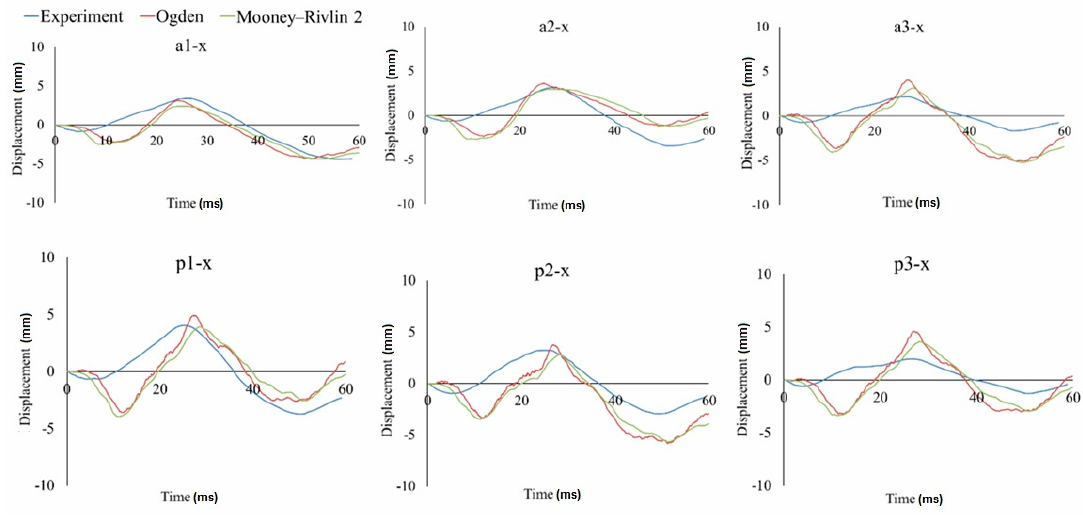
Figure 5. Displacement-in-time characteristics of the markers in the frontal (a) and rear columns (p) in the X-direction using the hyperelastic material models based on the second Mooney-Rivlin and Ogden constitutive equations.